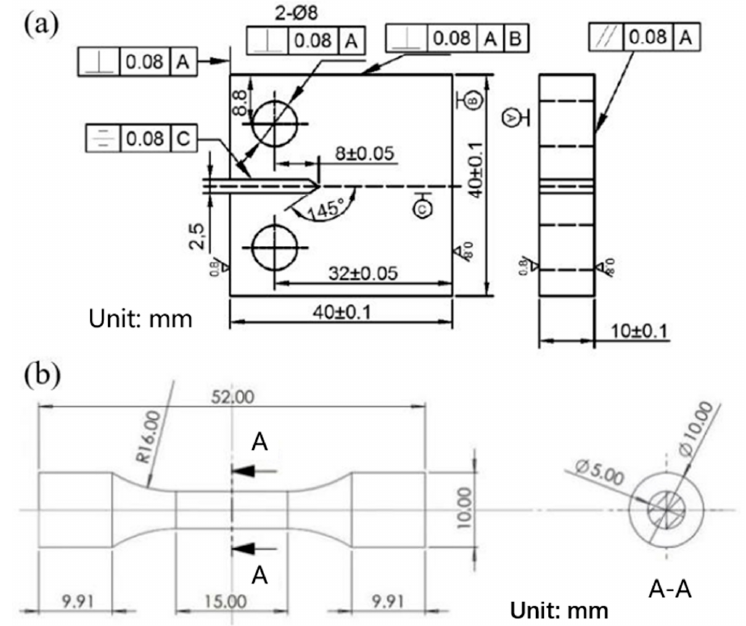
Figure 3. The dimensions of CT specimens ( a ) and fatigue specimens ( b